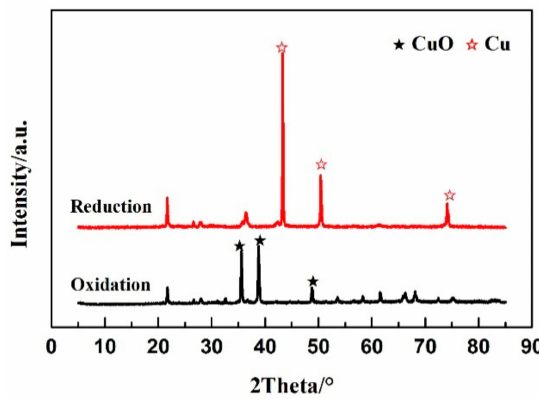
Figure 8. XRD results of reduced and regenerated CuO/Ben oxygen carrier.